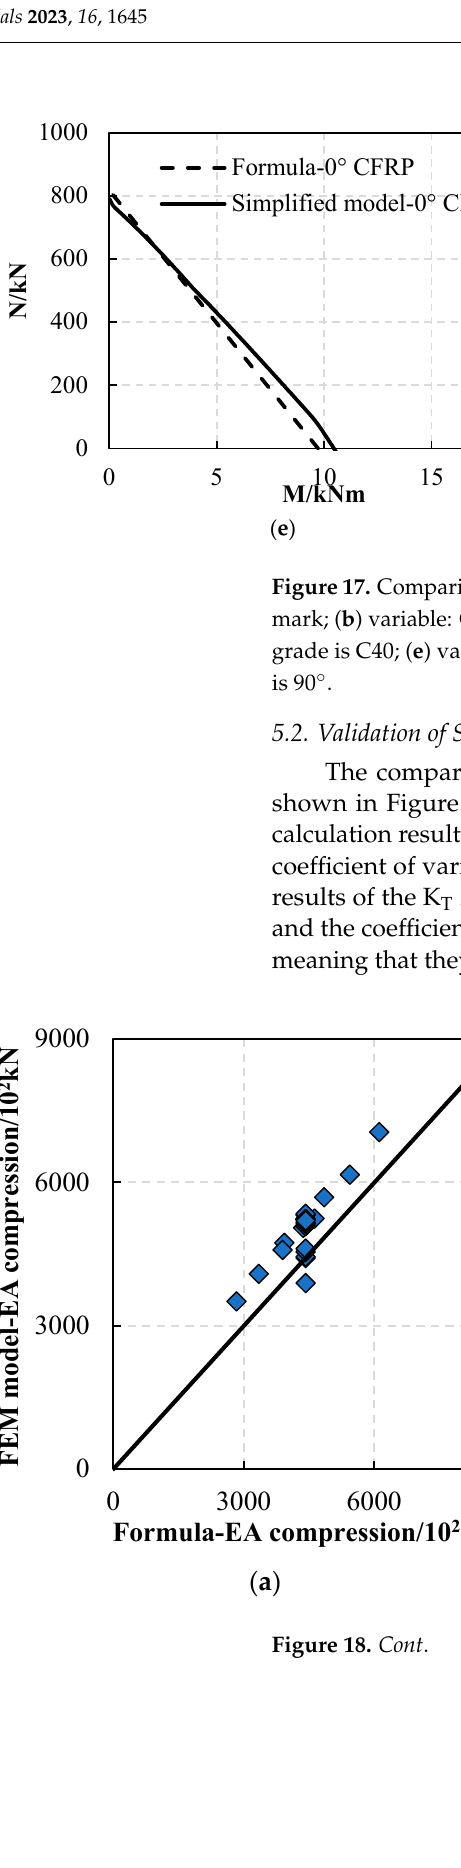
( c ) Figure 18. Comparison between the formula results and the numerical model results: ( a ) compres- sion stiffness; ( b ) tension stiffness; ( c ) bending stiffness. 5.3. Limitations The calculation method proposed here is based on the working mechanism of the FWPs. The formula is simple and can be calculated by hand. However, the results of the calculation method are relatively conservative, and the errors are within 15% according to Tables 10 and 11, except for the formula of bending stiffness. The calculation method results are less discrete from the test results. There have been few compression and bending tests carried out to verify the accu- racy of the calculation formulae to date, but it could also be verified by new component tests and numerical simulations for the practical application of tunnel reinforcements in the future. New approaches, such as neural networks [22,23], could be used to propose new methods for predicting the mechanical properties of FWPs in the future. 6. Conclusions In this paper, the mechanical behavior of FWPs was clarified through component tests, and a reliable FEA model of FWPs was established. The effects of the design pa-